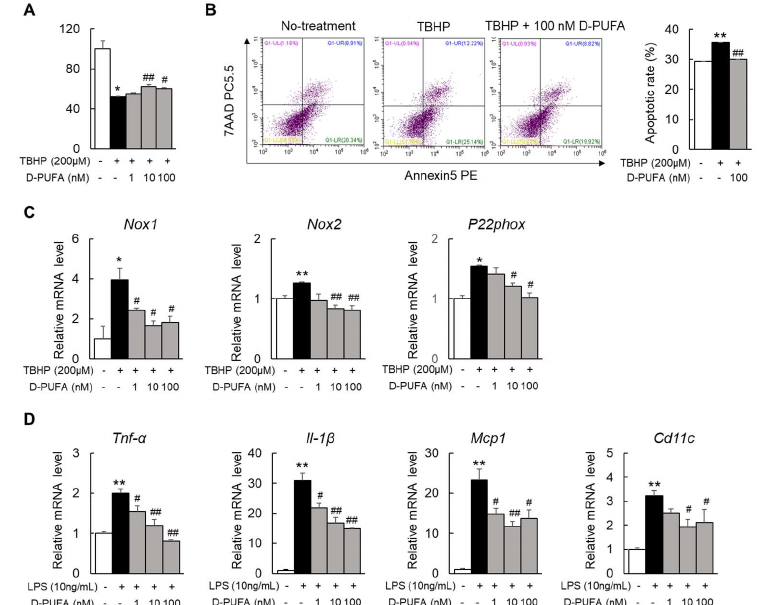
Figure 2. D-PUFAs reduced oxidative stress and inflammation in Raw 264.7 macrophages. ( A , B ) Cell viability and apoptotic rate in TBHP-treated Raw 264.7 cells. ( C ) mRNA expression of oxidative- stress-related genes in Raw 264.7 cells. ( D ) mRNA expression of LPS-induced inflammatory factors